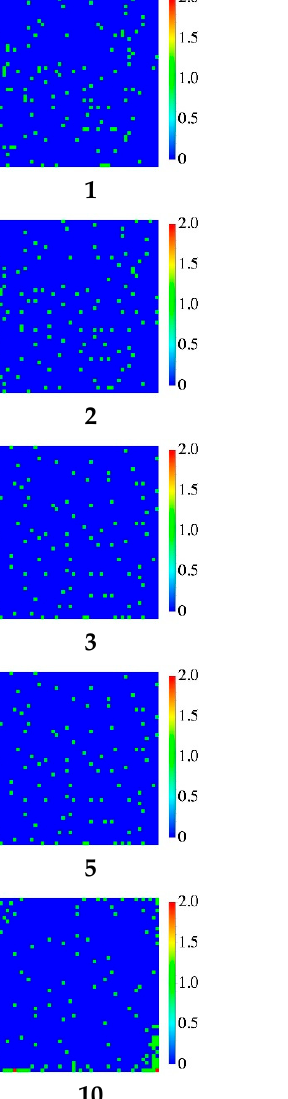
Figure 4. Colony formation in a square lattice. The color scale represents the Q values. The screenshots refer to a 50 × 50 network, initial amount of seeds, f 0 = 0.05, activity growth rate, σ = 22. This picture corresponds to Figure 3a (black dots).